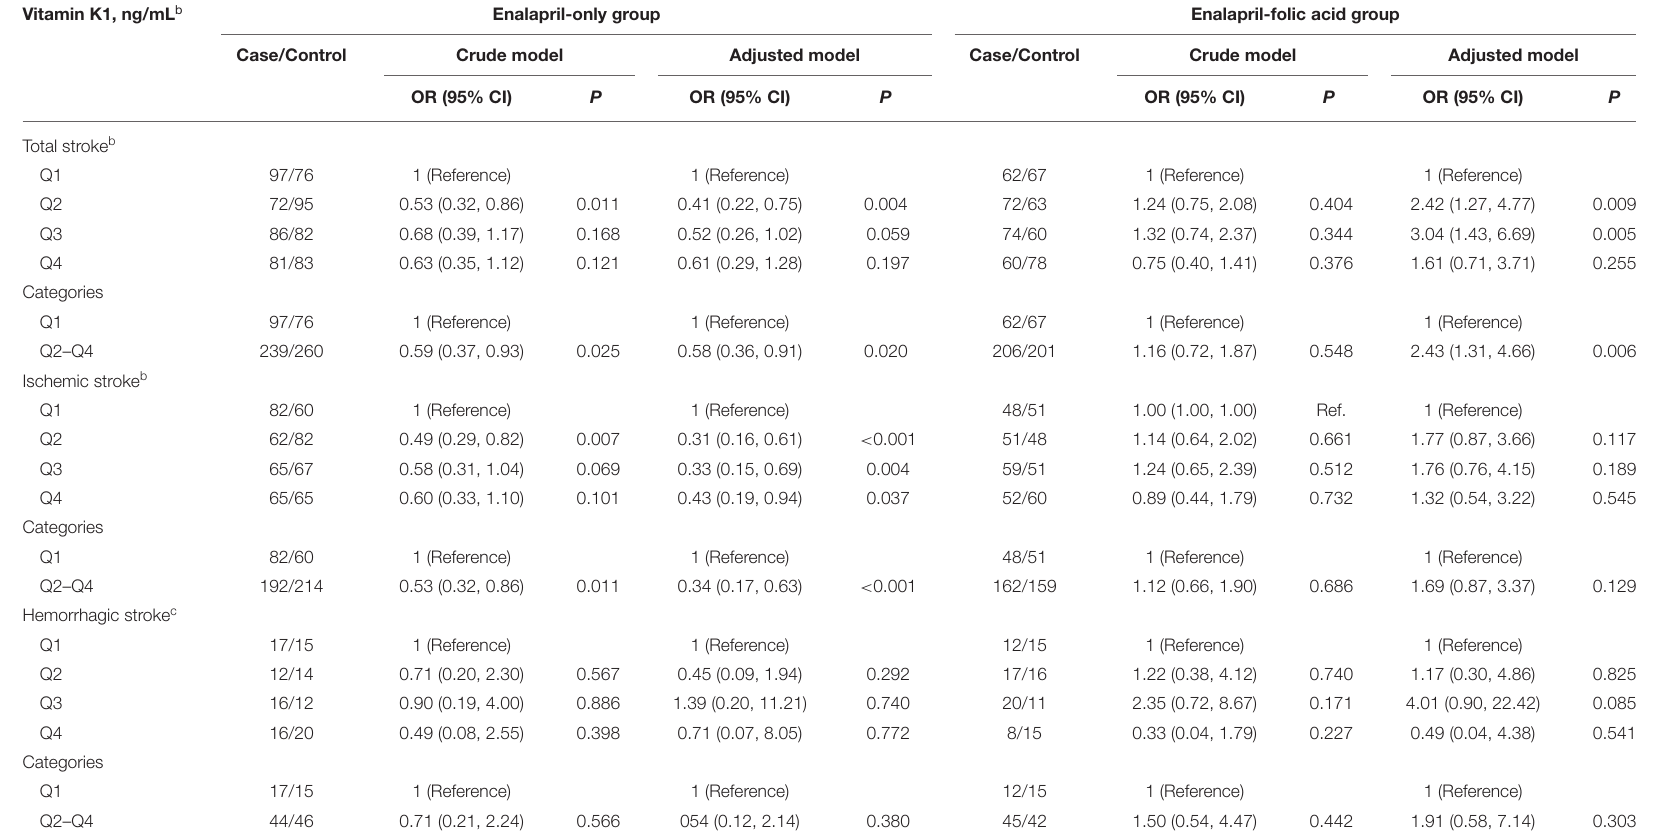
TABLE 3 | Baseline plasma vitamin K1 and the risk of first stroke (total and subtypes) by treatment group a . Vitamin K1, ng/mL